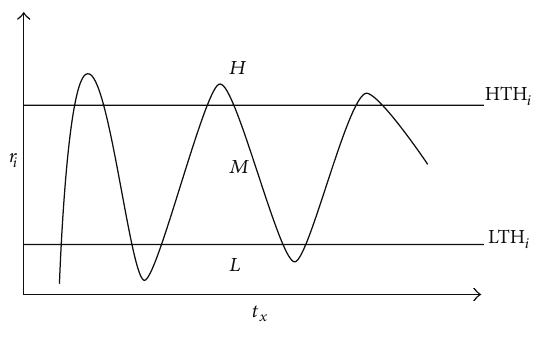
Figure 1: Sensor-reading